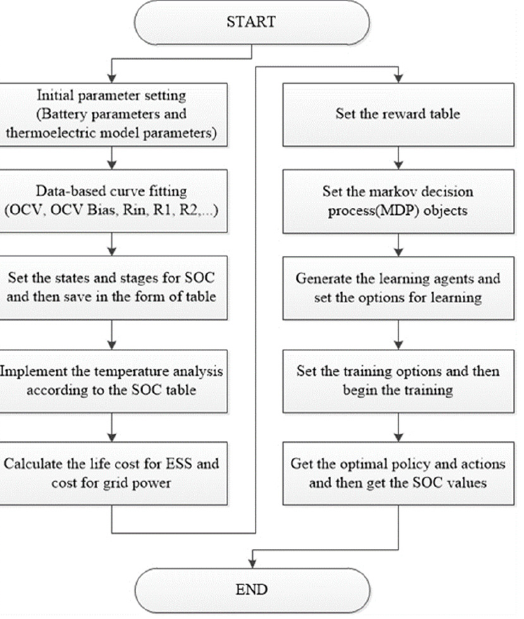
Figure 7. Flow chart of the optimization problem solution considering the life-cycle cost of ESS.